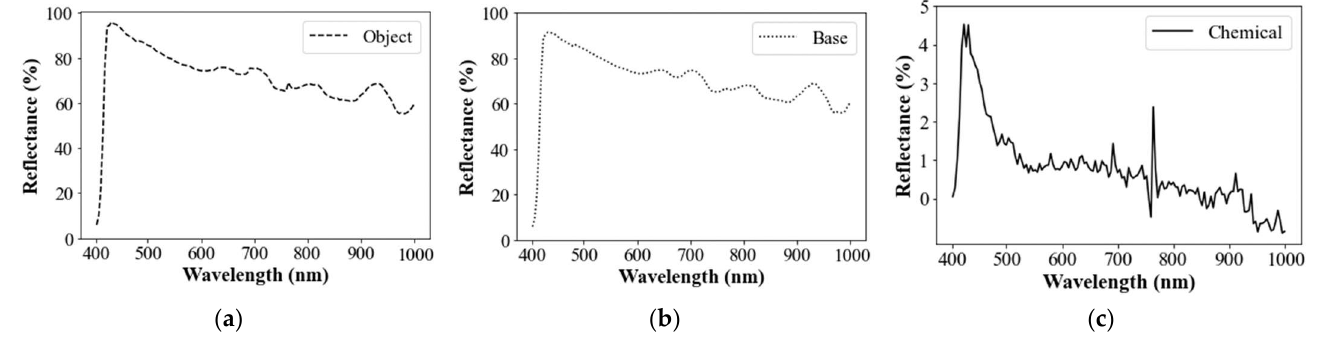
Figure 5. Derivation of spectral signature characterizing hazardous chemicals mixed with river water in terms of residual spectral pattern for solvent chemicals subtracted from a given pure river water. ( a ) Raw spectral signature exemplified for a solvent chemical mixed river water and hydrogen fluoride; ( b ) spectral signature of pure river water without any solvent chemicals; ( c ) residual spectral pattern for solvent hydrogen fluoride subtracting impact by pure river water.